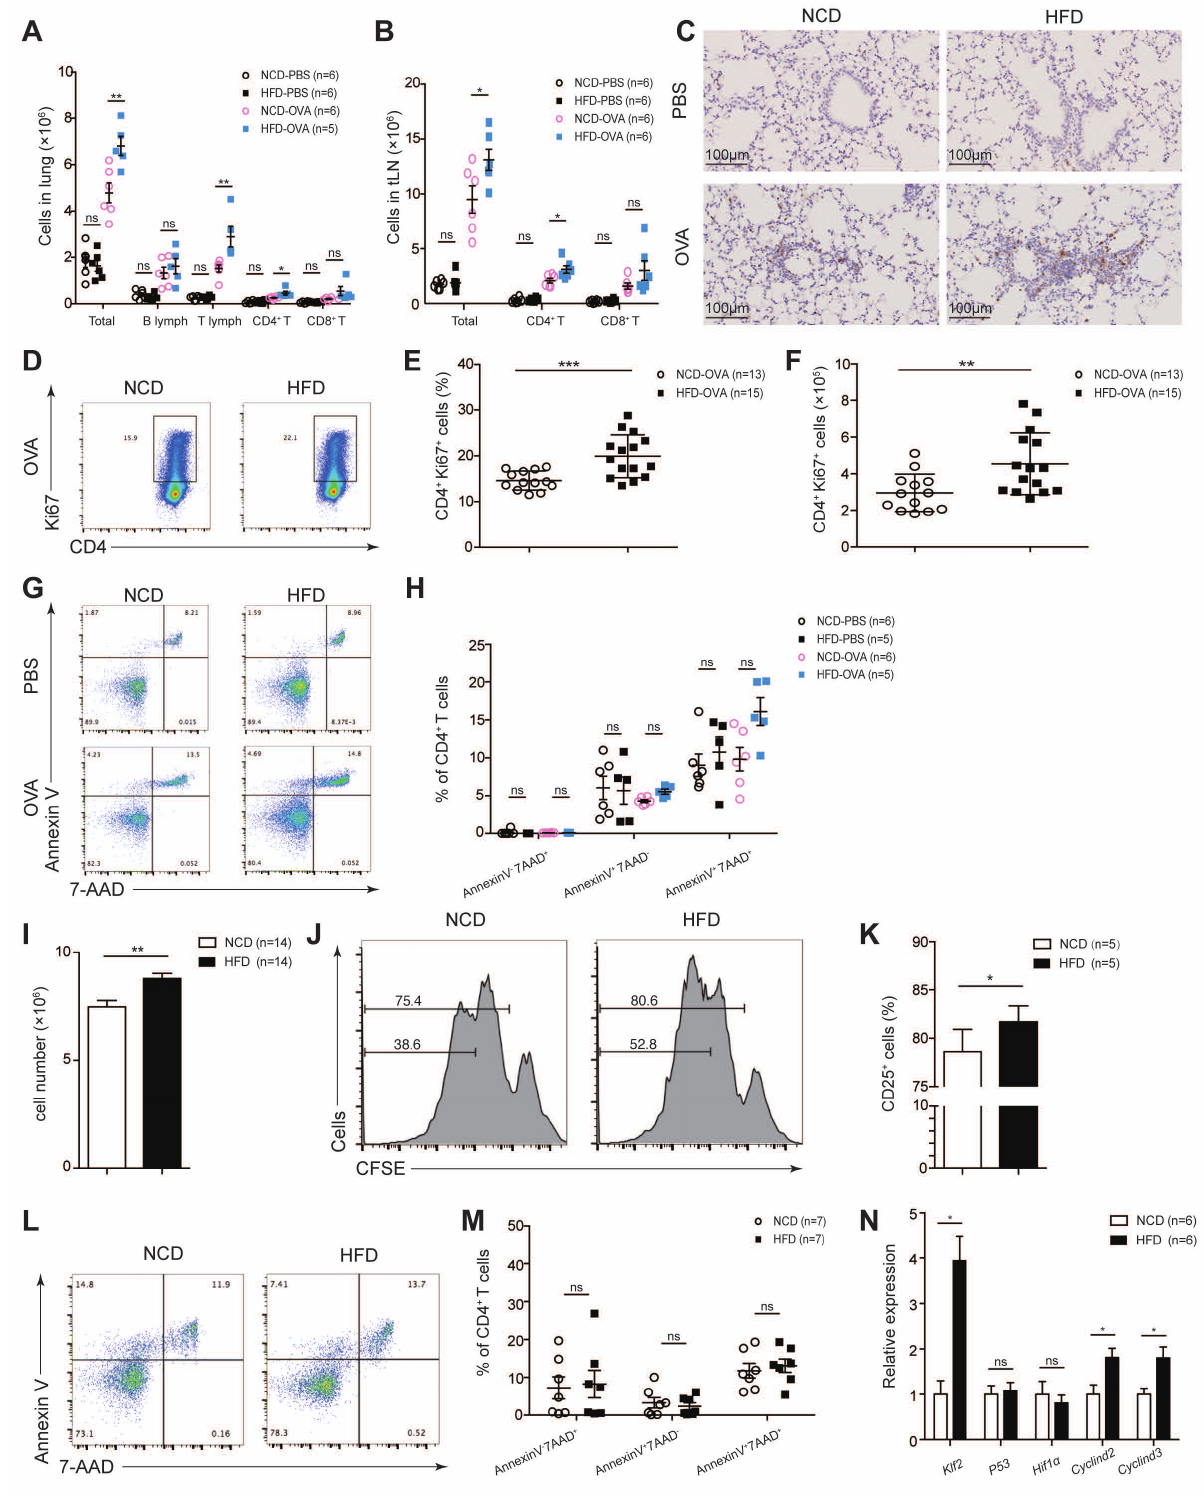
Figure 2. Maternal high-fat diet during pregnancy promoted CD4 + T-cell proliferation and activation in offspring. ( A – H ) OVA model. Quantifications of immunocytes in lungs ( A ), tracheobronchial lymph nodes (tLNs) ( B ), and microscopy of lung sections stained with CD4 antibody ( C ) were analyzed. Scale bars represent 100 µ m. Percentages ( D , E ) and quantifications ( F ) of Ki67 + CD4 + T-cells, the Annexin V and 7-aminoactinomycin D (7-AAD) staining of CD4 + T-cells ( G , H ) were measured